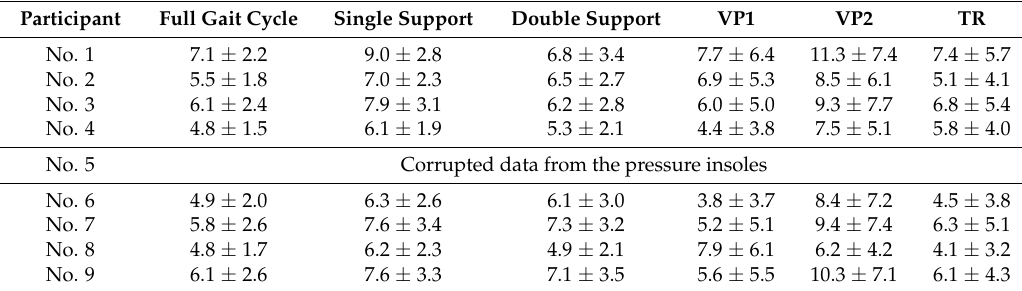
Table 5. Mean and SD of prediction errors for OFW (rRMSE %) based on C7 acceleration.